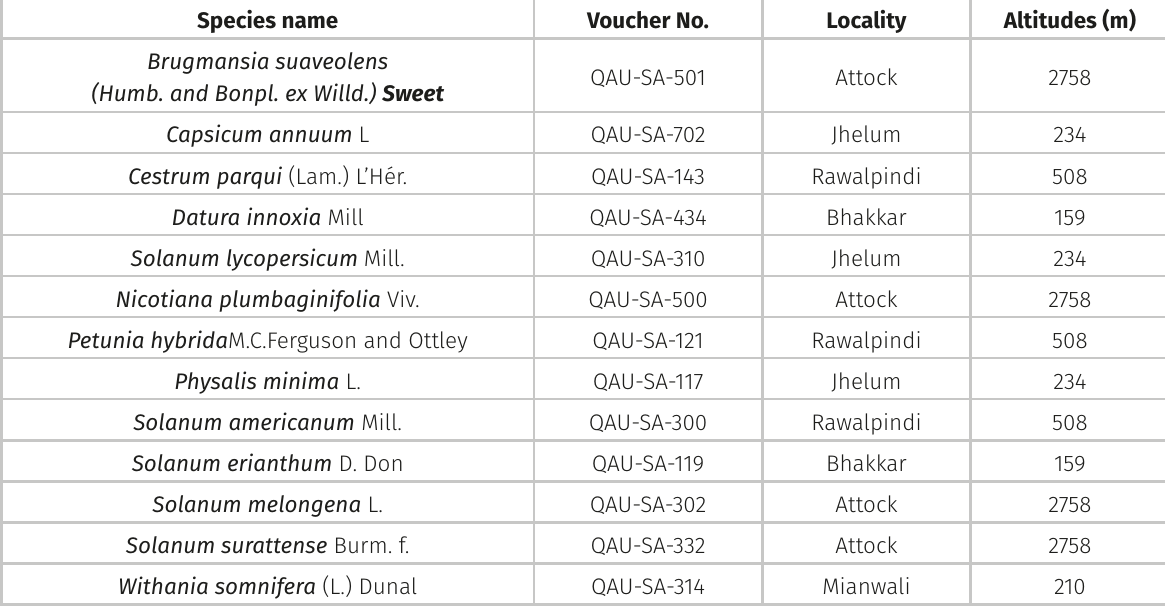
Table I. Locality and voucher numbers of the taxa